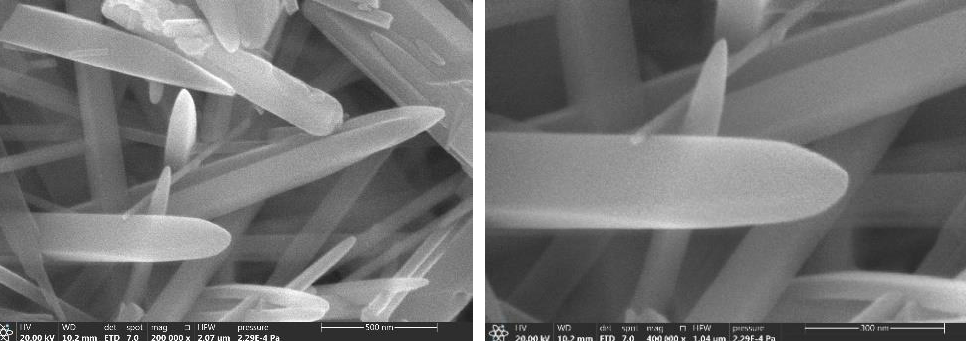
Figure 18. Magnified SEM images of mullite whiskers at 200,000 and 400,000 times (10% sodium sulfate, 5% AlF 3 ·3H 2 O, 825 °C, 5 h).